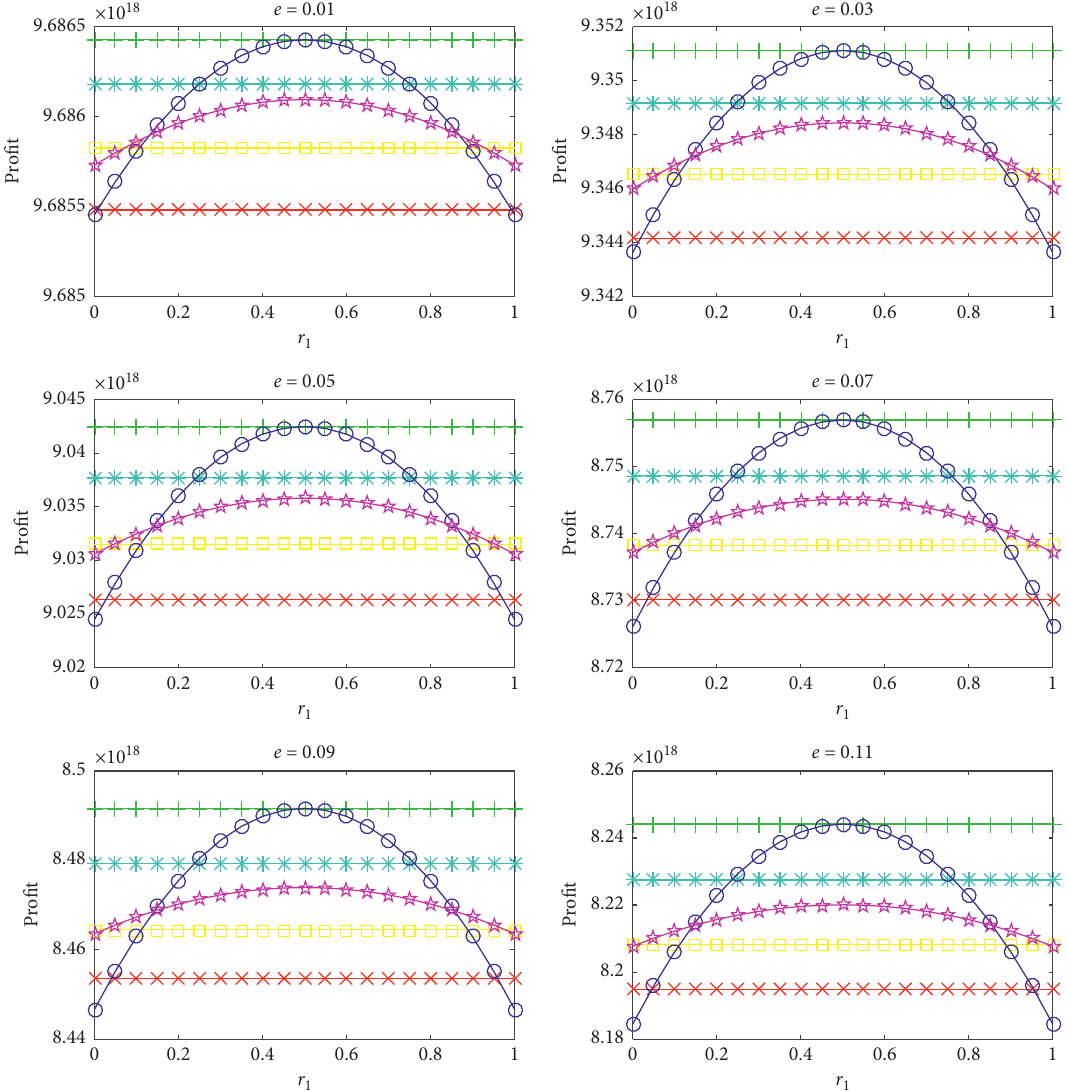
Figure 5: Change trends of the SC performance on combined sharing factors and nonscale economic cost. (a) e � 0.01. (b) e � 0.03. (c) e � 0.05. (d) e � 0.07. (e) e � 0.09. (f) e �